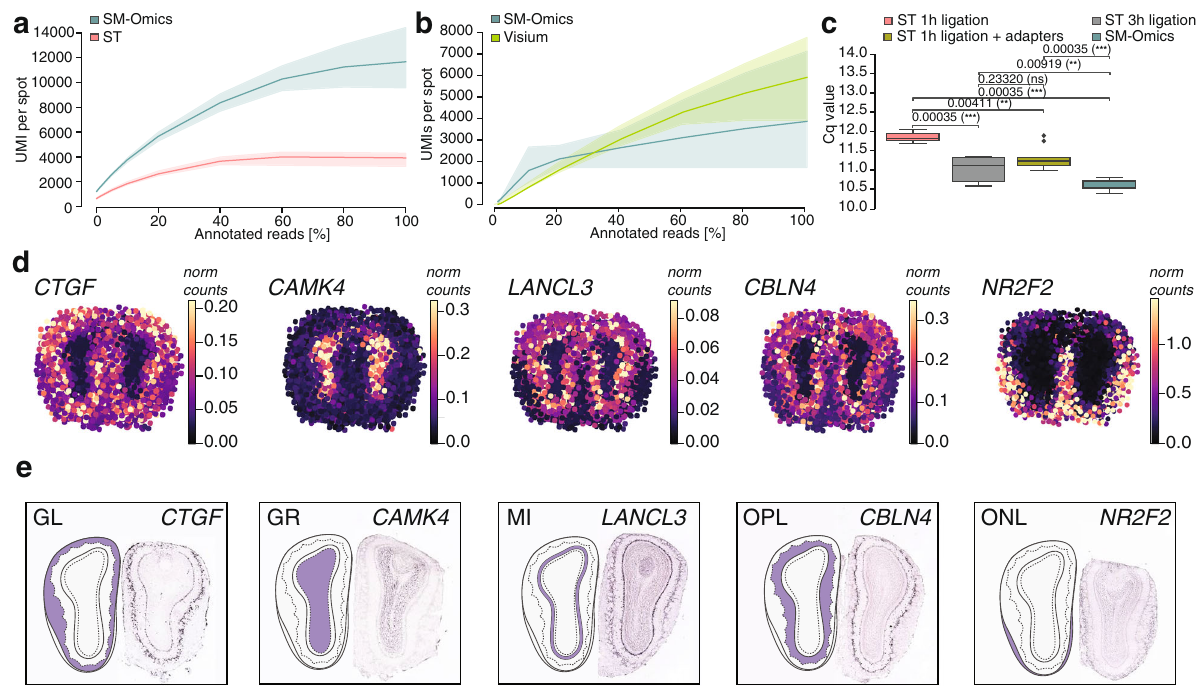
Fig. 2 SM-Omics performance. a , b Sensitivity of spatial gene expression measurements. Mean number of unique molecules detected ( y axis) at different proportions of annotated reads ( x axis) in a SM-Omics (blue, n = 3) and ST (red, n = 3) and b SM-Omics (blue, n = 3) and Visium (green, n = 3). Shaded areas: 95% con fi dence intervals. Colored line: mean of summarized library values ( n = 3) per condition. c Performance of automated spatial library preparation reactions. Impact of ligation reaction times and adapter concentrations on quantitative concentrations (Cq) values for automated prepared libraries ( n = 9). Cq values were measured at Fluorescent unit 10,000. Statistical signi fi cance (two-sided Wilcoxon ’ s rank-sum test) markings are displayed: 0.05 < p ≤ 1 (ns), 0.001 < p ≤ 0.01 (**), 0.0001< p ≤ 0.001 (***). Center black line, median; color-coded box, interquartile range; error bars, 1.5x interquartile range; black dots; outliers. Individual reaction conditions are detailed in Methods. d , e Spatial gene expression. d Examples of SM-Omics spatial gene expression patterns (normalized expression shown in color scale) detected in each of the major histological regions in the MOB of an adult mouse brain and e corresponding in situ hybridization images from ABA (Image credit: Allen Institute for Brain Science, Methods) for the same genes as in d with illustrated and highlighted region annotation patterns. Annotated region abbreviations: GL (glomerular layer), GR (granular cell layer), MI (mitral layer), OPL (outer plexiform layer) and ONL (olfactory nerve